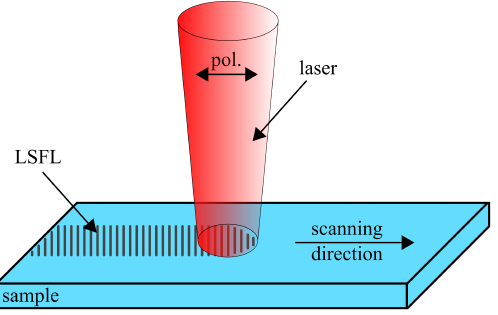
Figure 1. Schematic illustration of the experimental setup with the scanning direction being parallel to the polarization (pol.) of the